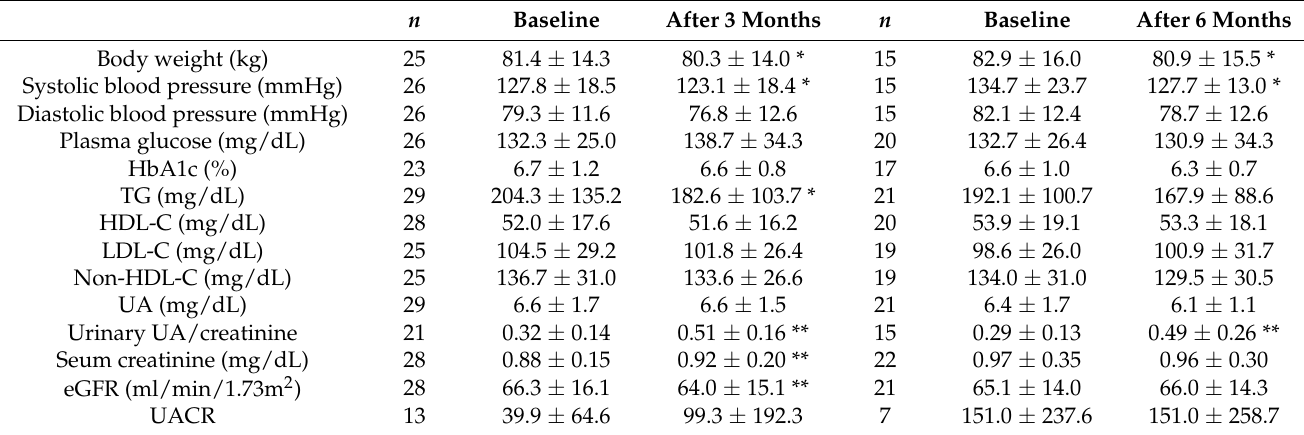
Table 7. Changes in metabolic parameters after the start of dotinurad in patients who had not taken anti-hypertensive drugs ( n = 34). n Baseline After 3 Months n Baseline After 6